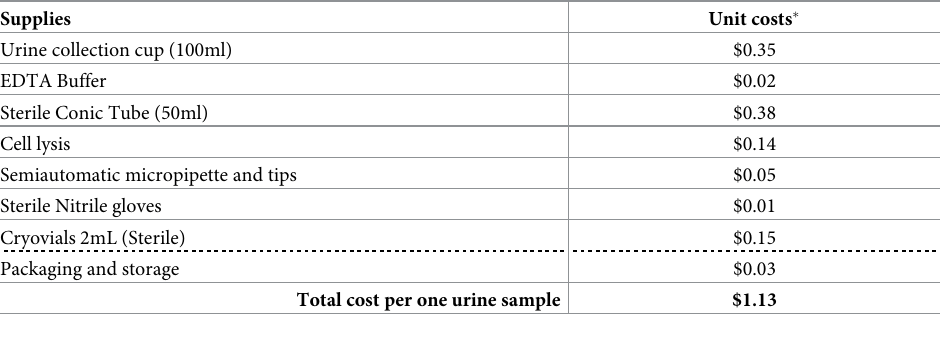
Table 2. Supplies for urine